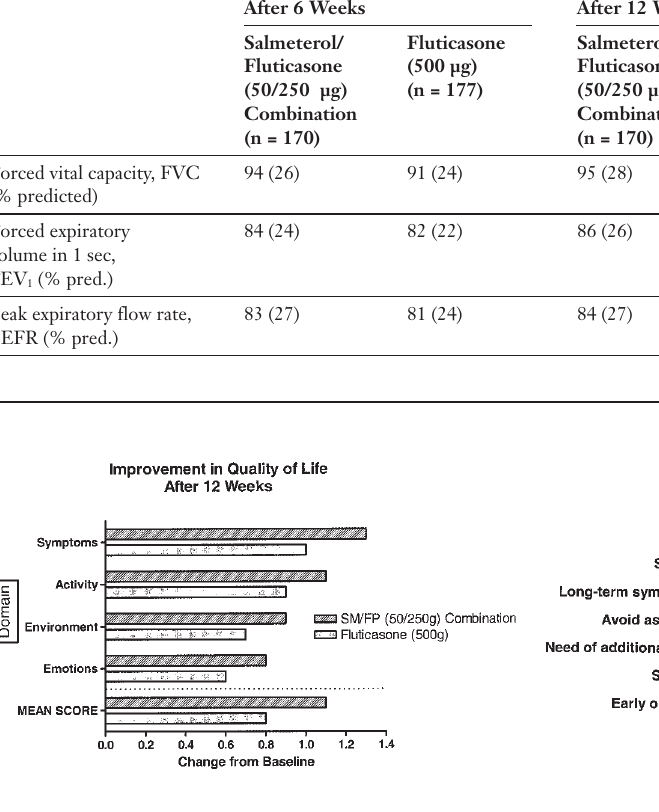
Figure 4 Improvement in quality of life.